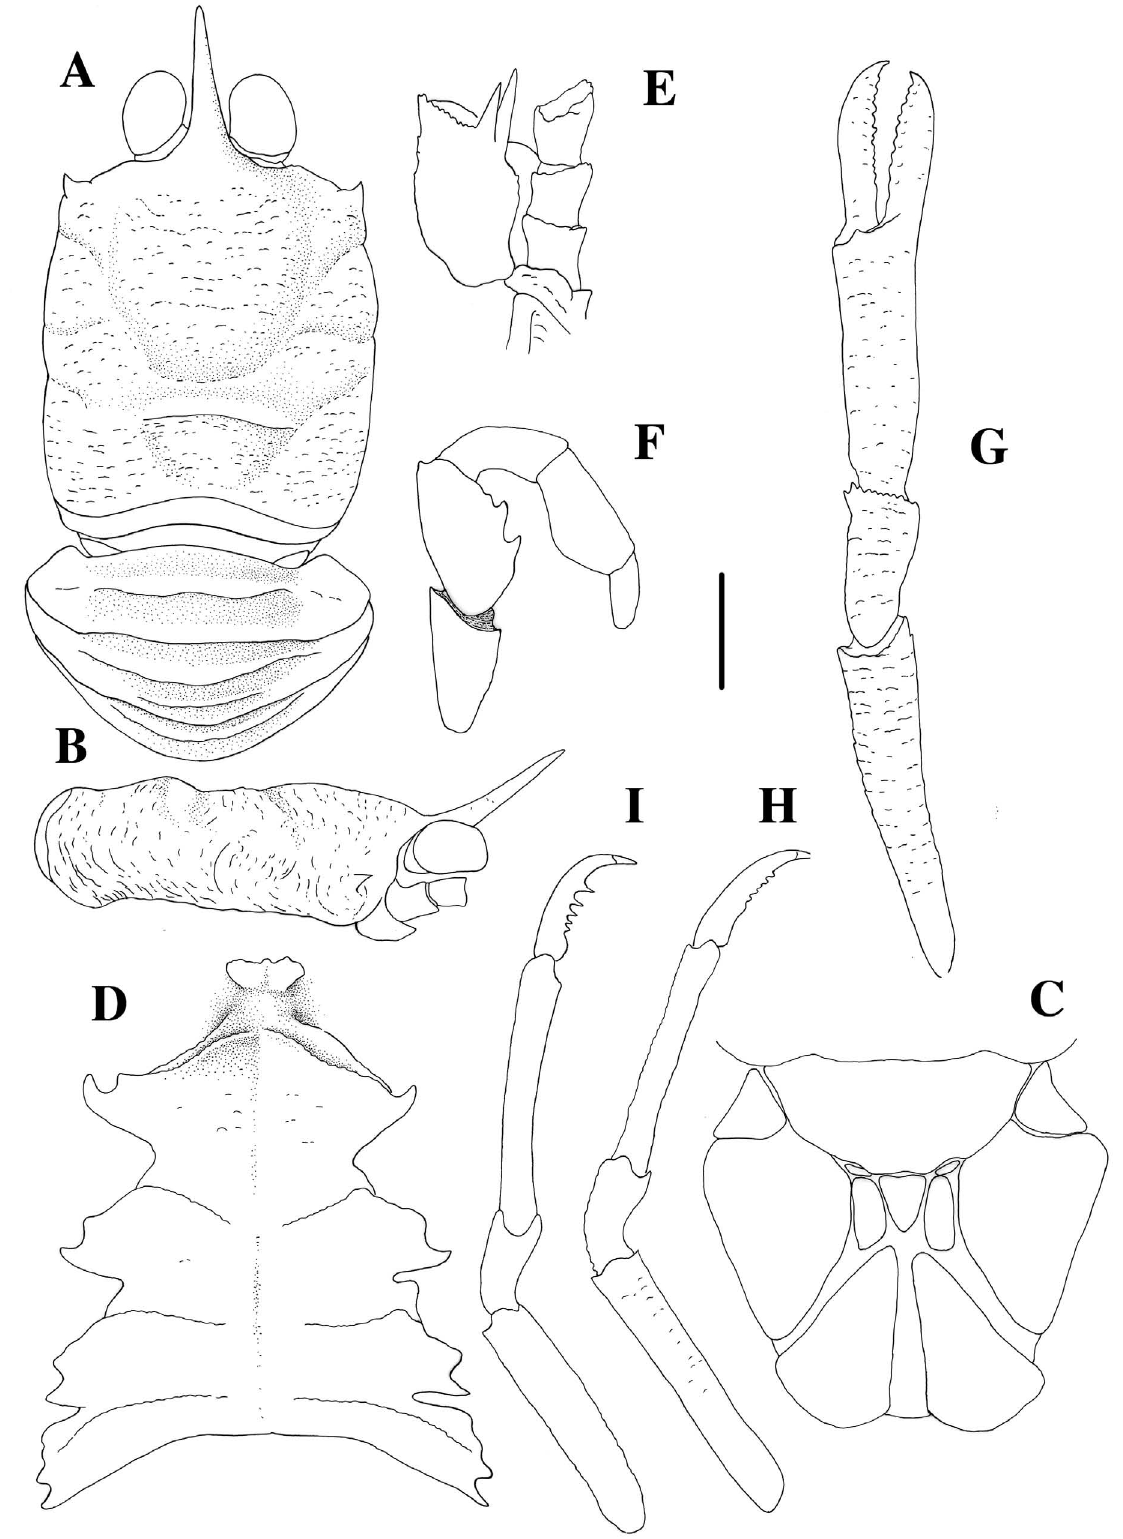
Fig . 4. – Munidopsis talismani A. Milne Edwards and Bouvier, 1894, female 7.0 mm (SM). A, carapace and abdomen, dorsal view. B, cara- pace, right lateral view. C, telson. D, sternal plastron. E, left antenna and antennula, ventral view. F, right maxilliped 3. G, right P1. H, Right P2. I, Right P4. Scale: A-B, 3.0 mm;, G-I, 2.0 mm; C-F, 1.0